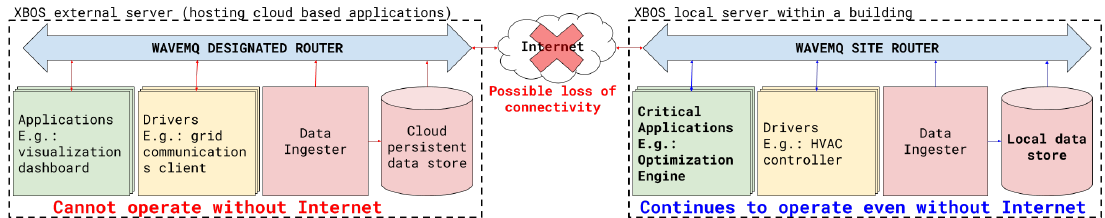
Figure 3. The services on the site router continue to run even during network